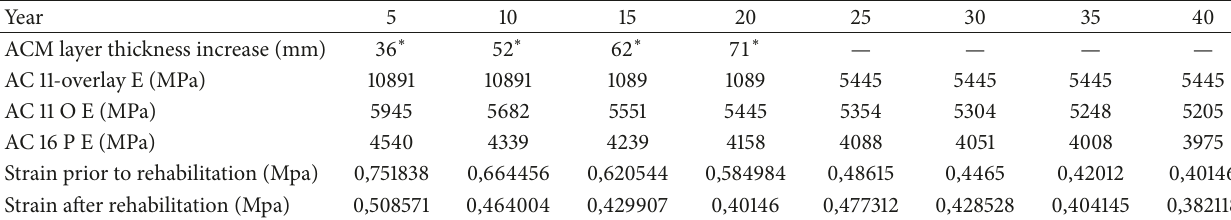
Table 4: Radial strains prior to and after overlay.